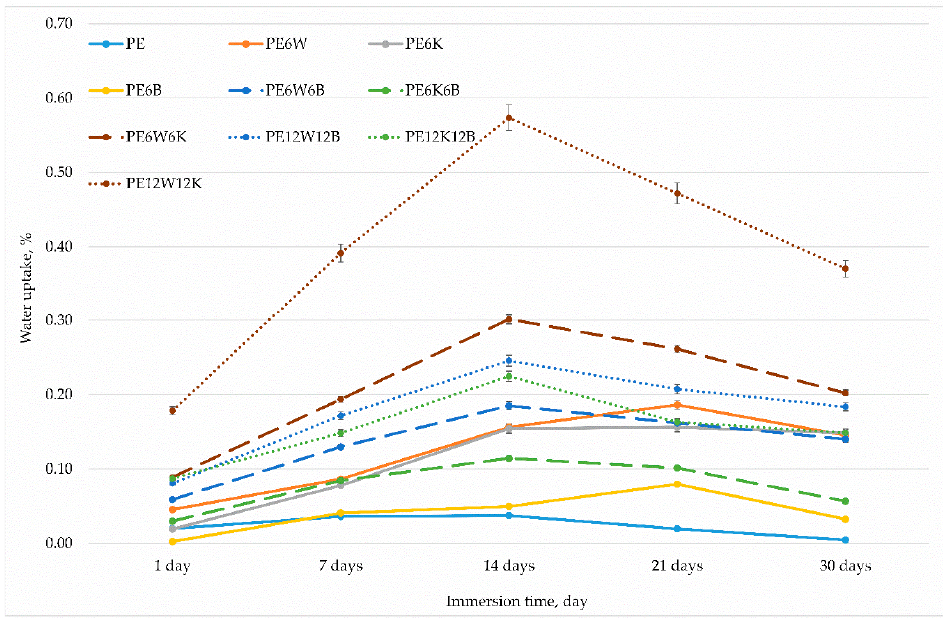
Figure 10. Water absorption after temporary immersion of samples in water.